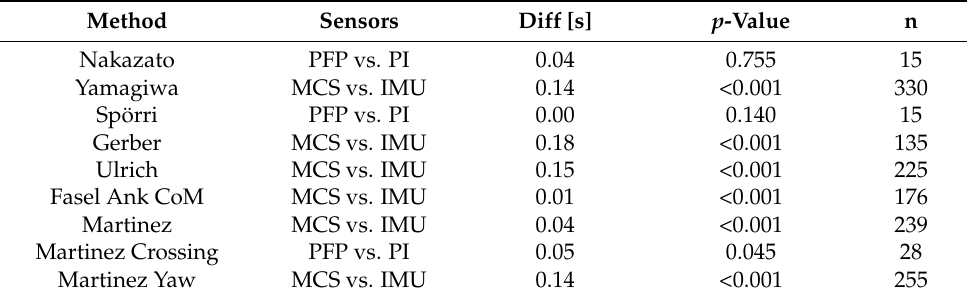
Table 2. List of methods assessed with two different sensors, the absolute median difference between both sensors and all the turns pooled together, and Wilcoxon signed ranks test